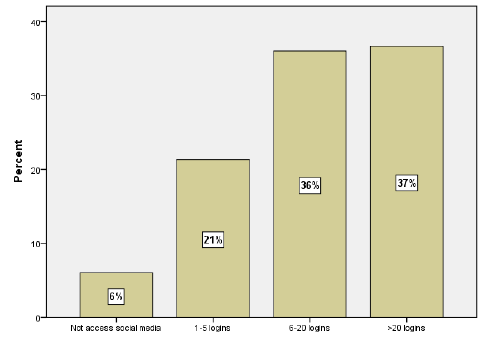
Figure 4: Bar chart showing percentage of respondent’s how often they visited social media site/app per day